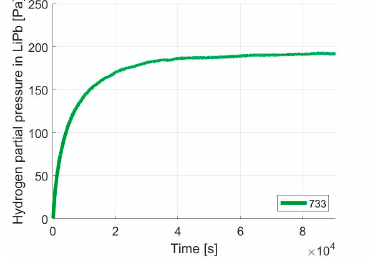
Figure 2. Pictures of the PAV mock-up at the end of the manufacturing.